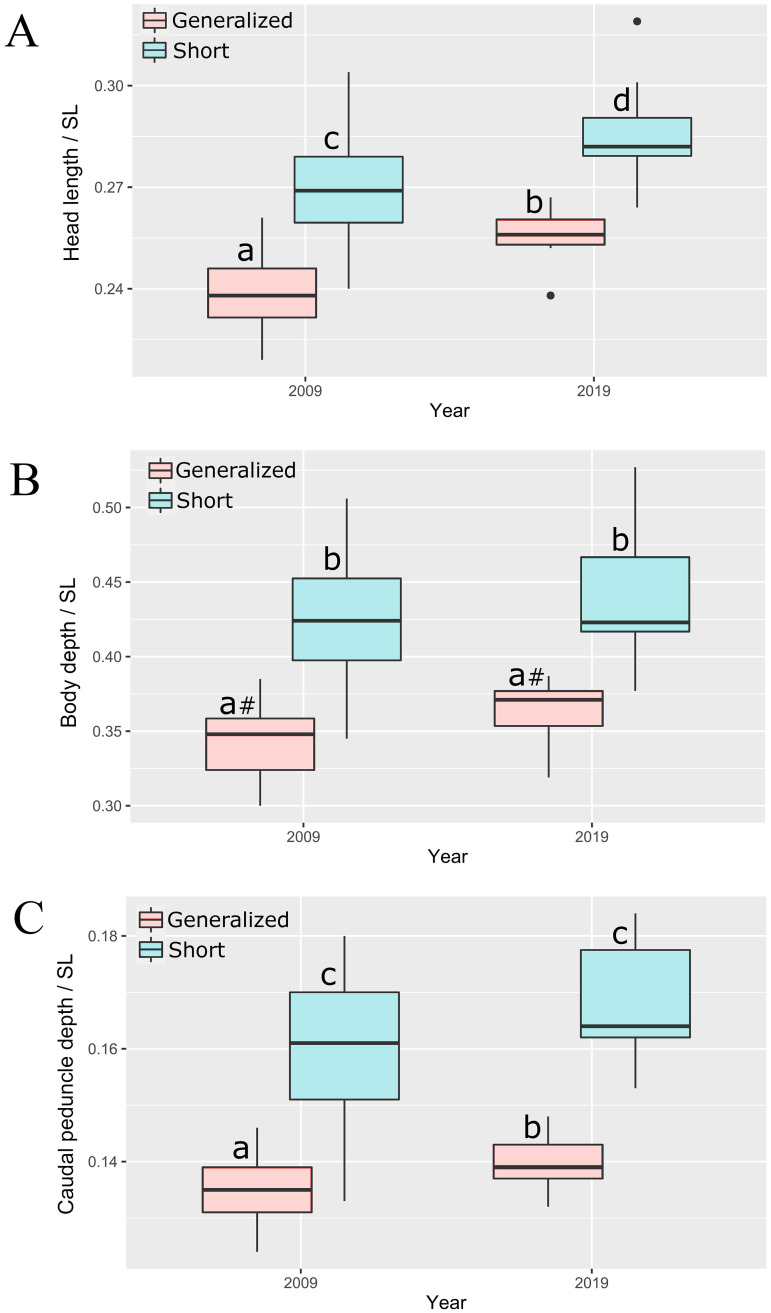
Indices of (A) head length, (B) body depth, and (C) caudal peduncle depth of generalized and short morphs sampled in 2009 and 2019.Median is shown as the horizontal black line inside the box. The box represents 1st and 3rd quartiles of variation. Lowercase letters above the boxplots indicate significant differences between morphs (p < 0.05, Mann-Whitney U test; #—nearly significant, p = 0.054).